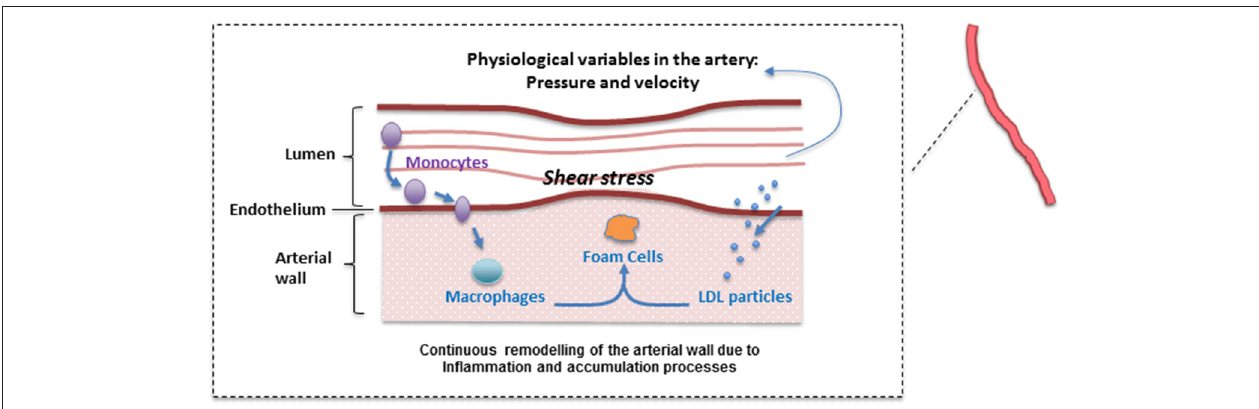
FIGURE 1 | Simplified atherosclerotic process. A plethora of mechanisms at different levels (hemodynamic, cellular, sub-cellular, etc.) are involved in plaque formation. Please note that this is a “positive feedback loop” with nested/coupled processes. Species concentrations in the lumen and the arterial wall (and the WSS) are affected by changes in the arterial wall. Arterial hemodynamics will be affected by arterial remodeling and this in turn, will affect the accumulation of lipids inside the arterial wall.